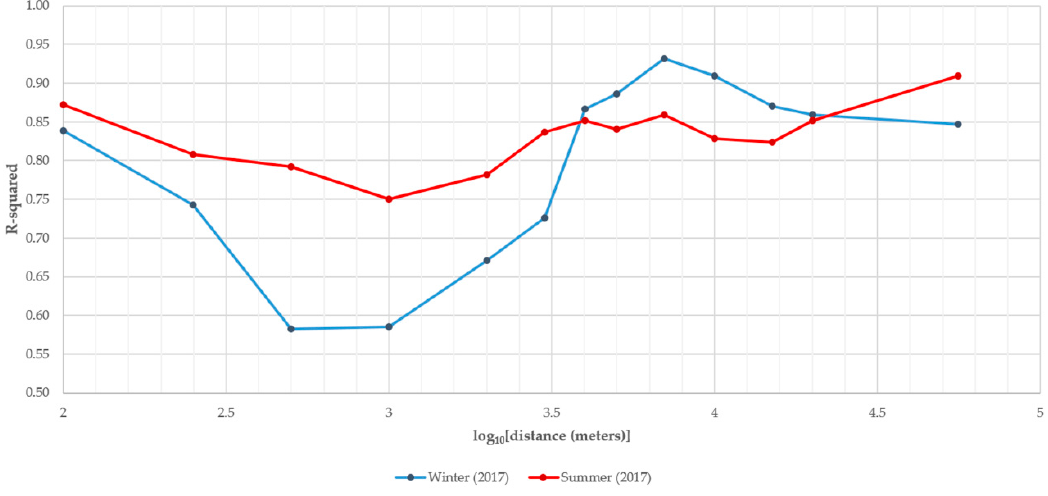
Figure 6. PLS-PM R-squared values.